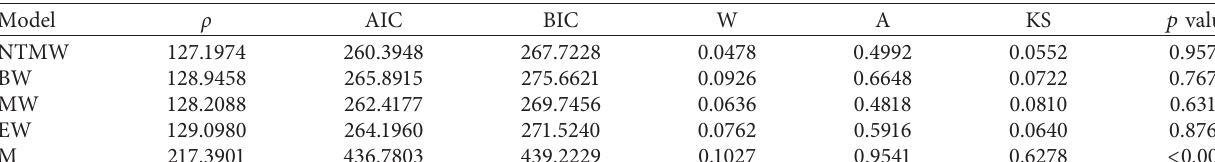
Table 12: Values of the considered criteria for dataset II.